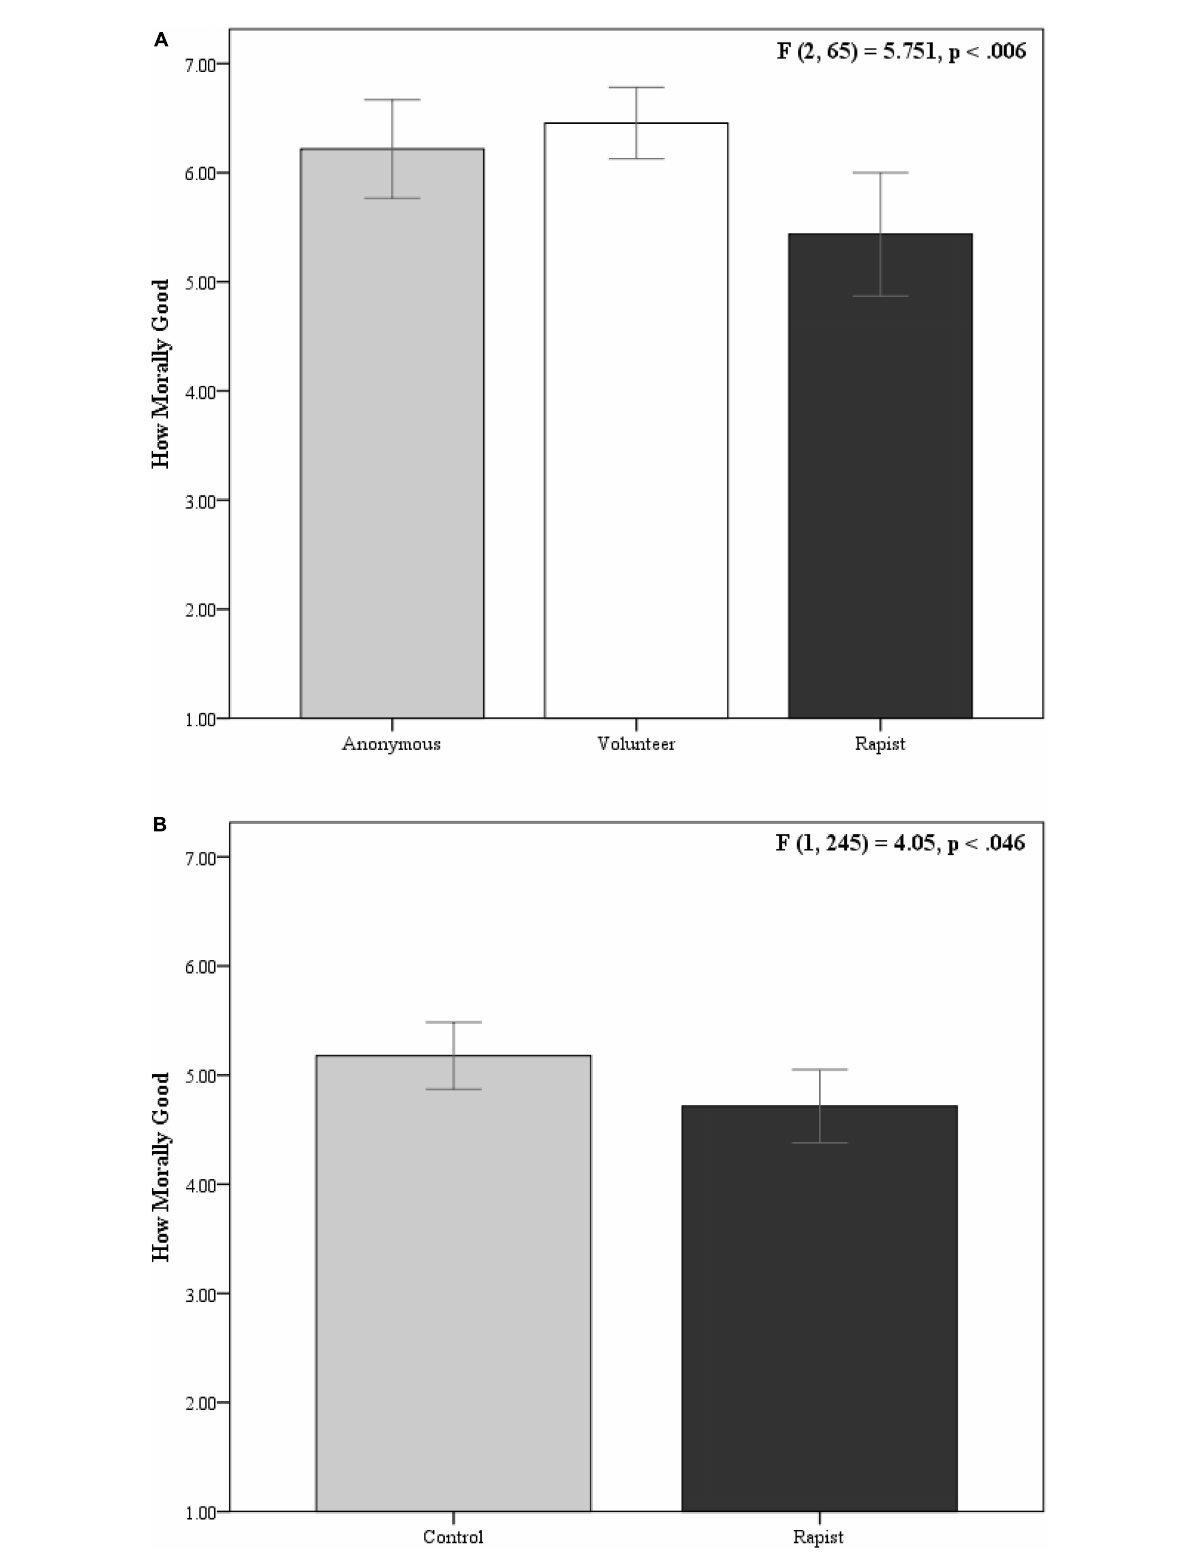
FIGURE1 Differences in the moral status of the same action, for the same reasons, performed by different people. Error bars represent 95%CI. (A) Shows results from the pilot study; (B) shows results from the replication.